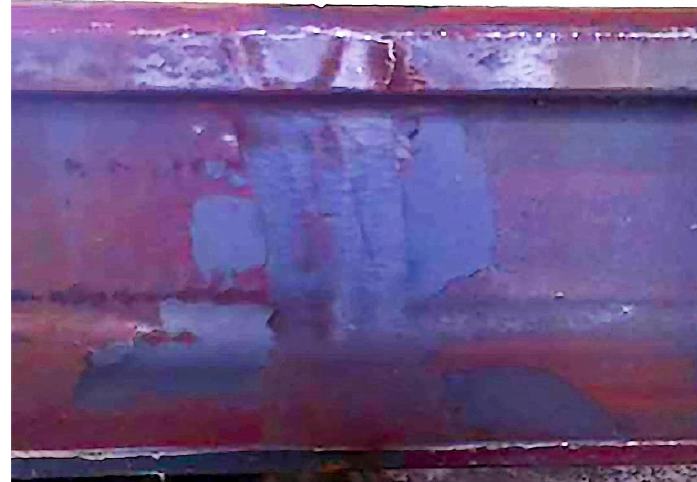
Figure 8. Welded joint. Table 2. Chemical composition of the tested steel.